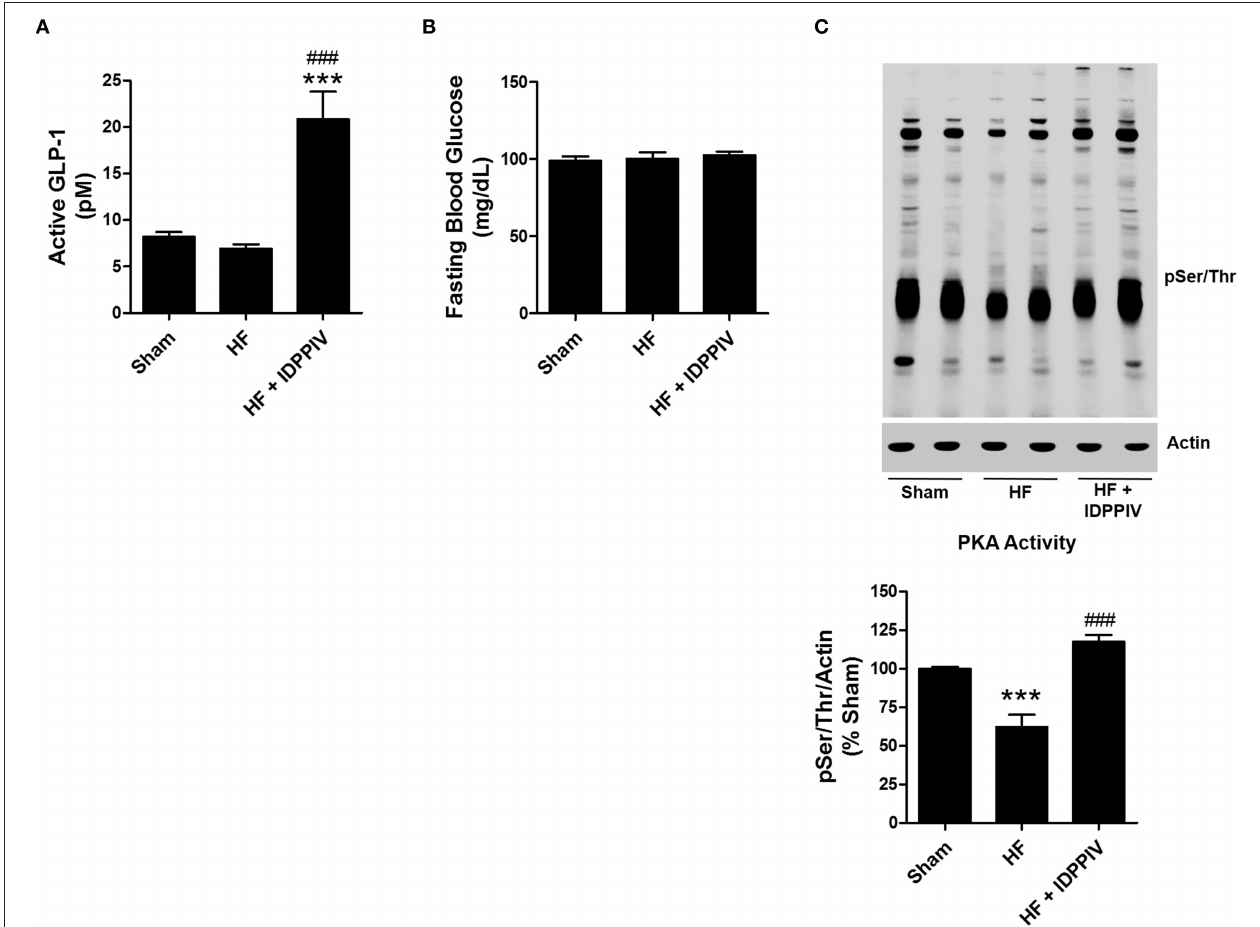
FIGURE 5 | DPPIV inhibition increases active GLP-1 serum concentration as well as renal cortical GLP-1R expression and PKA activation in HF rats. (A) Serum levels of active GLP-1 were determined by ELISA in sham and HF rats treated with vildagliptin (HF + IDPPIV) or vehicle (HF). (B) Fasting glucose serum levels in sham, HF rats and HF rats treated with vildagliptin. n = 11–17 rats/group (A,B) . (C) Levels of phosphorylation of PKA substrates in the renal cortex of Sham, HF and HF rats treated with vildagliptin (HF + IDPPIV) were evaluated by immunoblotting using an antibody that recognizes proteins containing a phospho-Ser/Thr. Top: Equal amounts of protein (25 µ g) from each rat were subjected to SDS-PAGE, transferred to a PVDF membrane and incubated with the antibody anti-pSer/Thr. Actin was used as an internal control. Bottom: The sum total of all phospho-PKA proteins per lane was estimated by densitometry and normalized by actin. The combined data from 6 experiments are represented as columns in a bar graph. Values are means ± SEM. *** p < 0.001 vs. Sham. ### p < 0.001 vs.